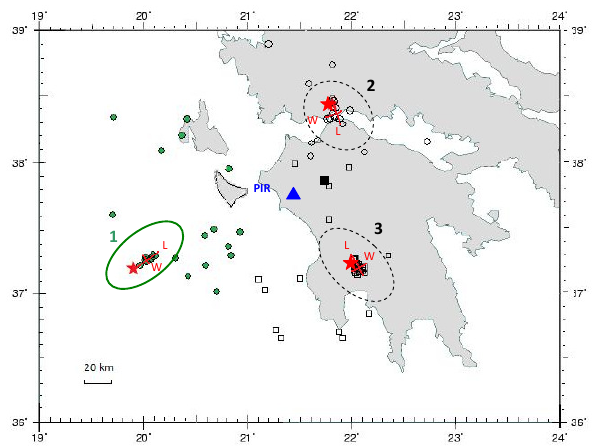
Fig. 1. Map of Greece, with the distribution (forming a cluster) of aftershocks with M L ≥ 3 reported by NOA for a three month period after each main shock listed in Table 1. Ellipses, one solid (no. 1) and two dashed (no. 2 and 3), show the location of each cluster with dimensions W and L for the corresponding aftershock area, while red stars numbered as 1, 2 and 3 denote the epicentres of the associated main shocks of Table 1. The epicenters of aftershocks are denoted by solid green circles for no. 1 event, open circles for no. 2 event and open squares for no. 3 event. A blue triangle depicts the location of the SES station PIR.